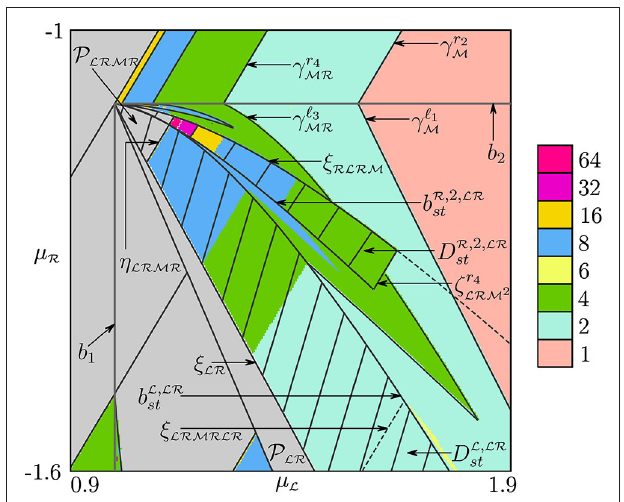
FIGURE 10 | Bifurcation structure related to chaoticity regions associated with the PA-region P LR and its left 2 · 2-fin P LRMR . The regions D L , LR st and D R ,2, LR st are shown dashed.